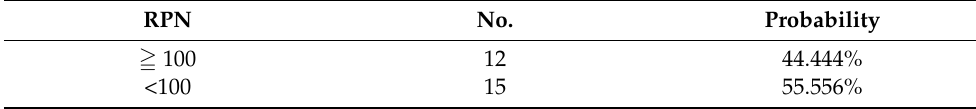
Table 6. Case 1: Probability of RPN (criterion: 100).